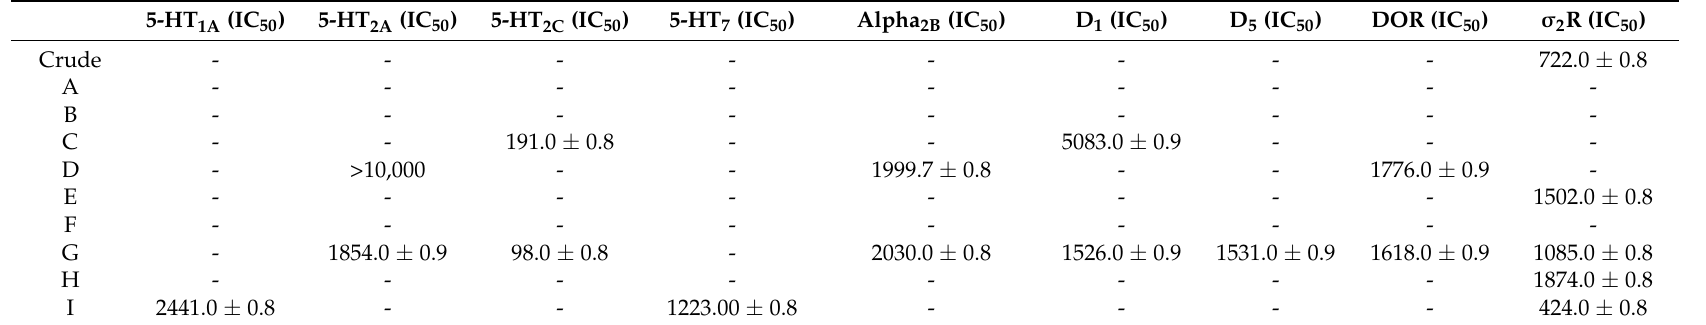
Table 1. IC 50 values of DUQ0008 crude extract and fractions at active